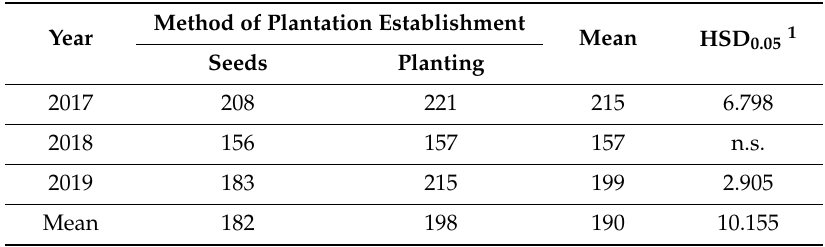
Table 4. The height of Silphium plants harvested for biomass (cm), depending on methods of plantation